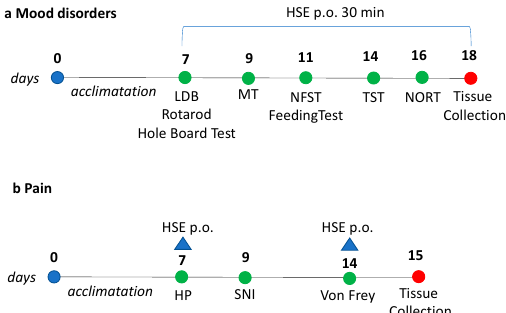
Figure 6. ( a ) Schematic representation of behavior experiments (LDB: light dark box; MT: marbles test; NFST: novelty suppressed feeding test; TST: tail suspension test; NORT: novel object recognition test). ( b ) Schematic representation of pain experiments (HP: hot plate; SNI: spared nerve